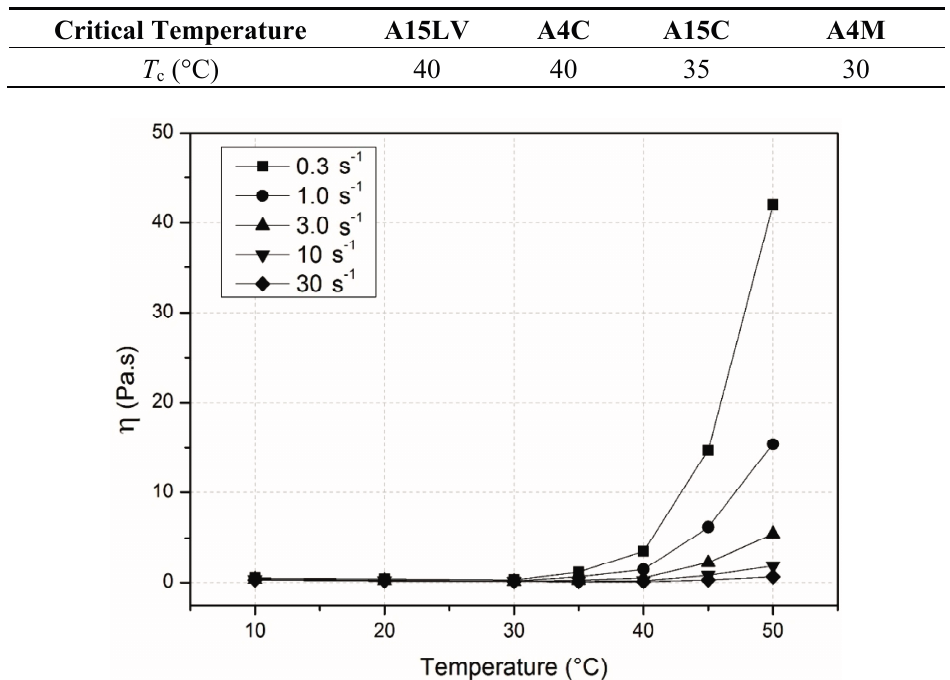
Table 4. Critical temperature ( T c ) of commercial methylcellulose in aqueous solution for the appearance of non-Newtonian behavior.